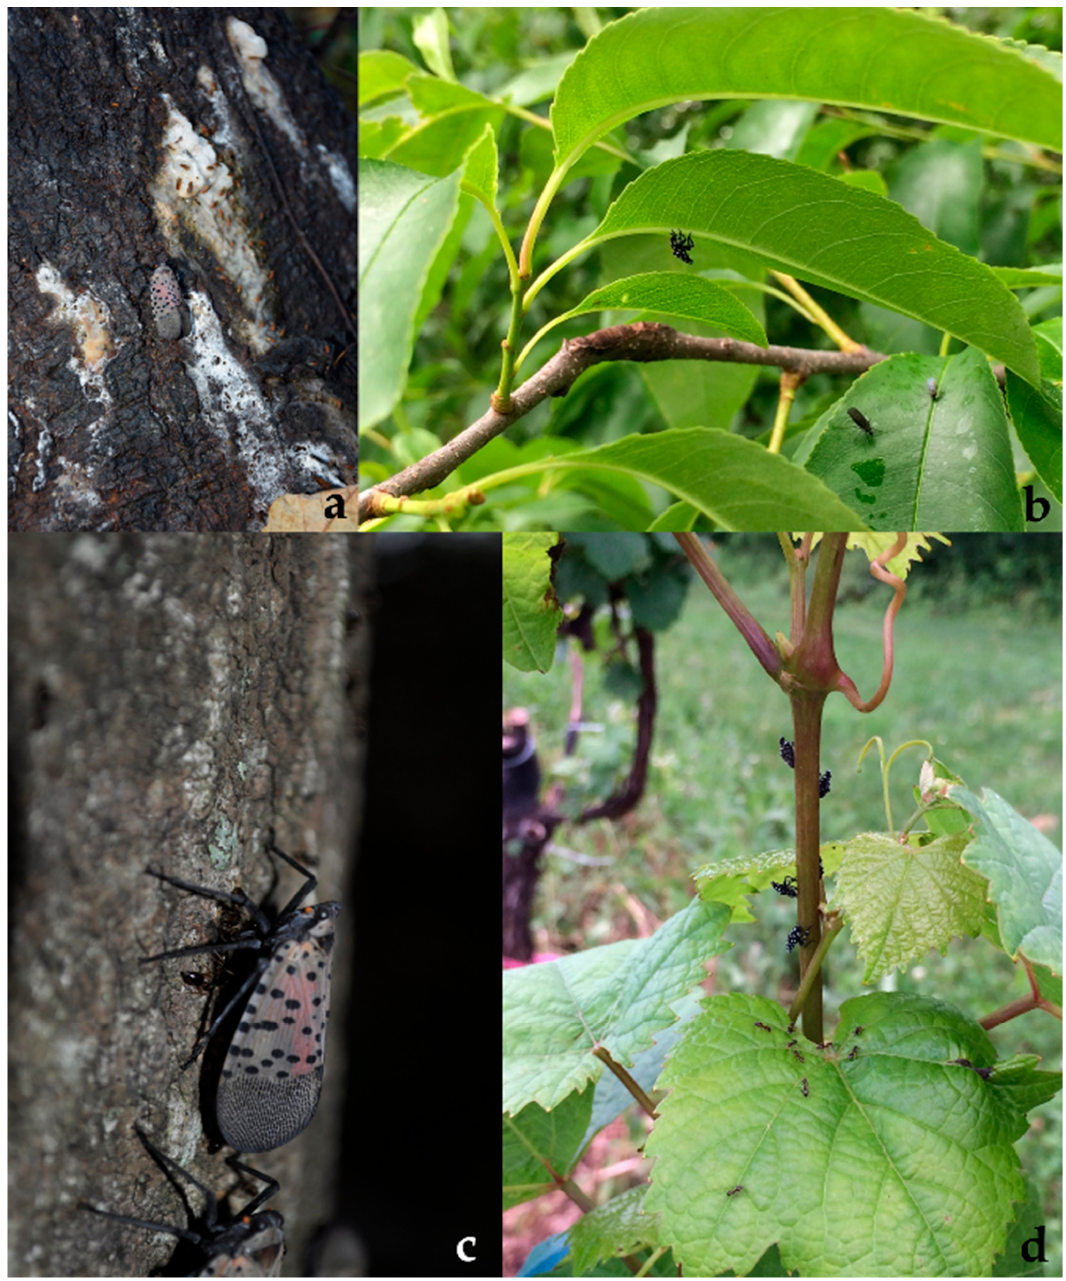
Figure 11. Fulgoridae: ( a ) Lycorma delicatula (White, 1845) tended by Diptera indet., USA: Pennsyl- vania, Berks County, Berks, Oley, 25.09.2017, on tree trunk, obs. E. Smyers; ( b ) L. delicatula tended by Diptera indet., USA: Pennsylvania, Berks County, Berks, Oley, 21.05.2017, nymph on tree leave, obs. E. Smyers; ( c ) L. delicatula tended by Formicidae indet., USA: Pennsylvania, Berks County, Berks, Oley, 25.09.2017, adults on tree trunk, obs. E. Smyers; ( d ) L. delicatula tended by Formicidae indet., USA: Pennsylvania, Berks County, Boyertown, 20.06.2017, nymphs on Vitis sp. (Vitaceae), obs. E. Smyers.